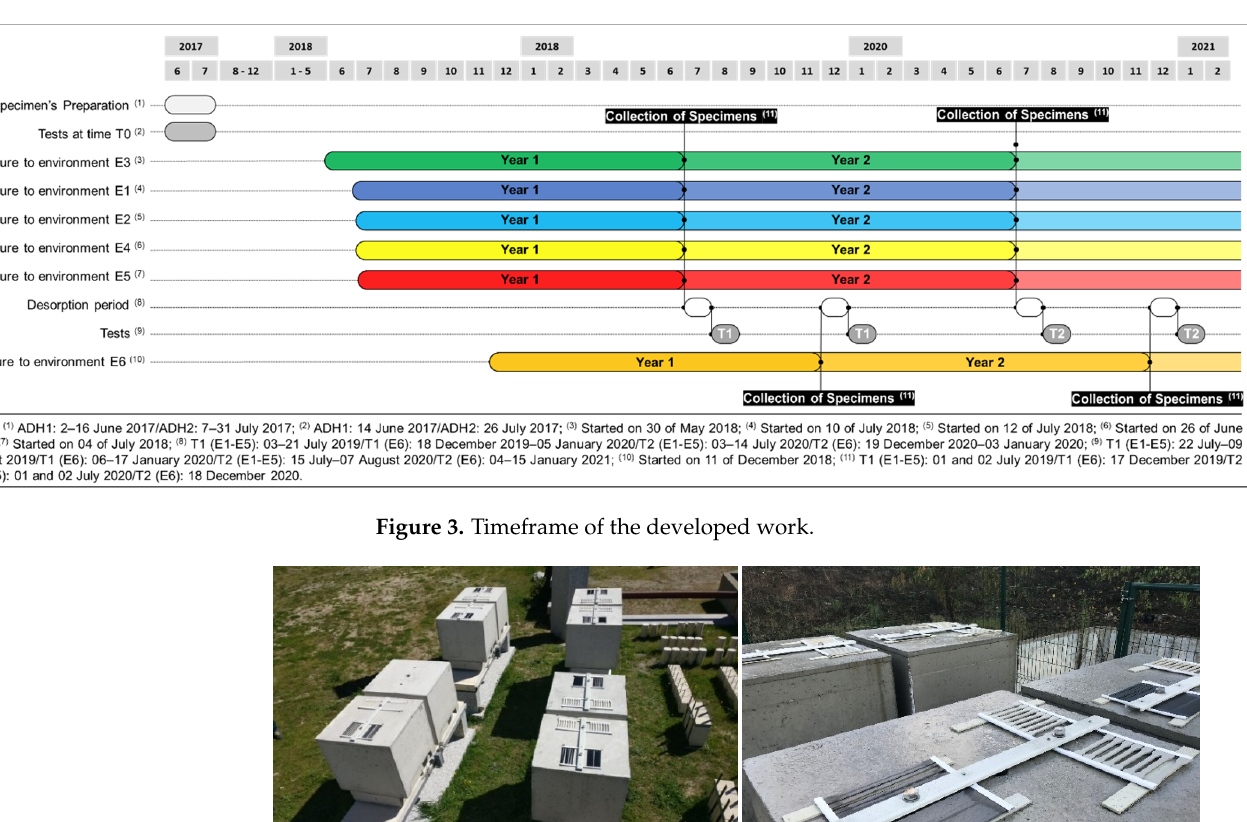
were sealed onsite and were only exposed to the desorption process one week before test- ing, with the hygrothermal conditions defined for E1. In the case of CFRP laminates, a three-week desorption period was adopted. During this period, the L50 CFRP strips were cut into the 15 mm wide test specimens. In the case of the specimens immersed in water (E2), no desorption process was adopted and all specimens were kept fully immersed all the time (only being removed immediately before testing). The transportation, desorption process, and test protocol used in both T1 and T2 experimental campaigns was the same, to achieve a direct results comparison and an accurate evaluation of the durability of the materials under each environment.